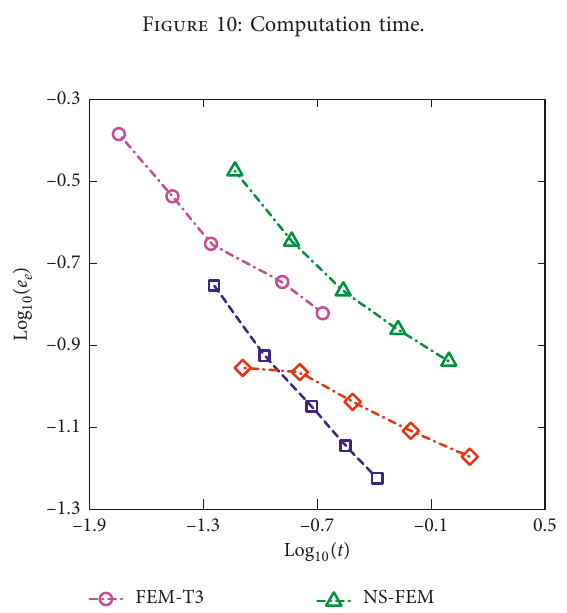
Figure 10: Computation time.